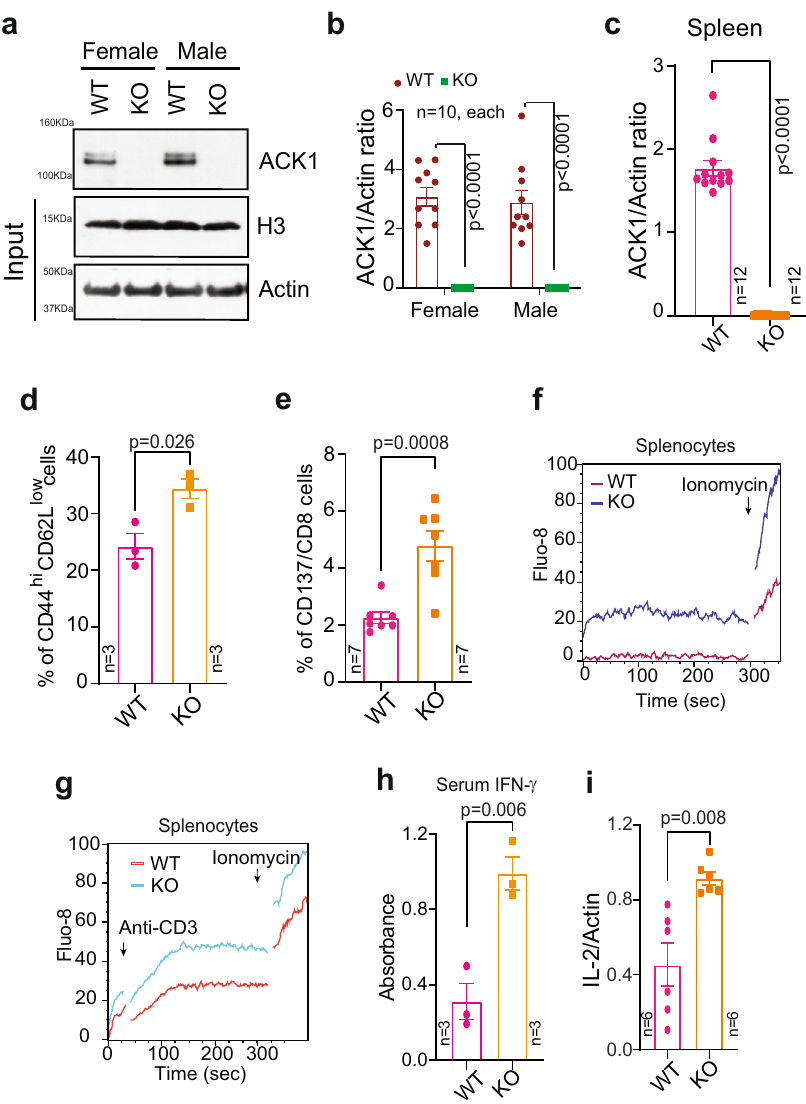
Fig.1|Geneticablationof Ack1 endowsmouseprimaryTcellswithenhancedT cell responsiveness. a Brain lysates from WT and Ack1 KO mice were immuno- blotted with ACK1 antibody. H3 and Actin were used as input controls. b RNA